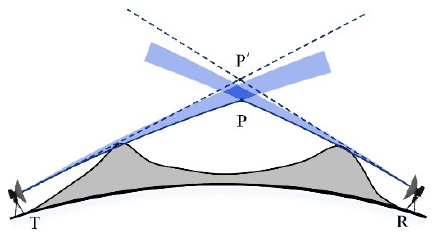
Figure 1. Geometric con fi guration of troposca tt er links.